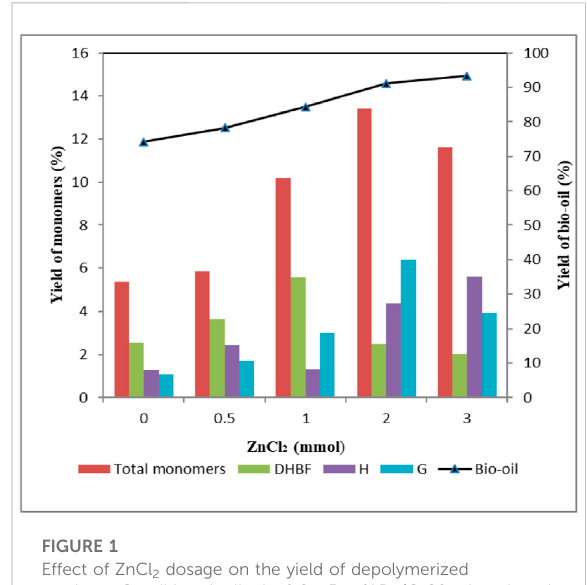
FIGURE 1 Effect of ZnCl 2 dosage on the yield of